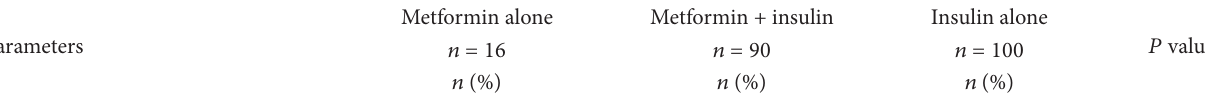
Table 2: Maternal outcomes in treatment groups ( 𝑛 = 206